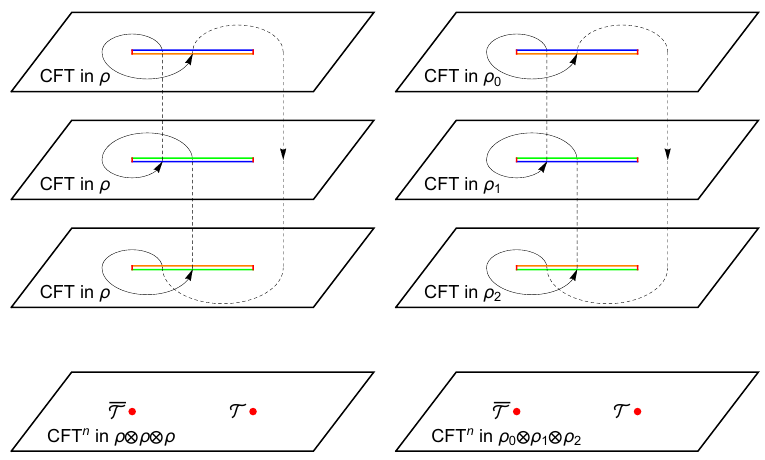
Figure 1 . The replica trick to calculate tr A (cid:26) n , eq. (2.3), (left) and tr A ( (cid:26) A; 0 (cid:26) A; 1 (cid:1) (cid:1) (cid:1) (cid:26) A;n (cid:0) 1 ), A eq. (3.5), (right). Top: path integral in terms of Riemann surfaces. Bottom: equivalent repre- sentation in terms of the twist operators in CFT n . We show the case n = 3 as an example.